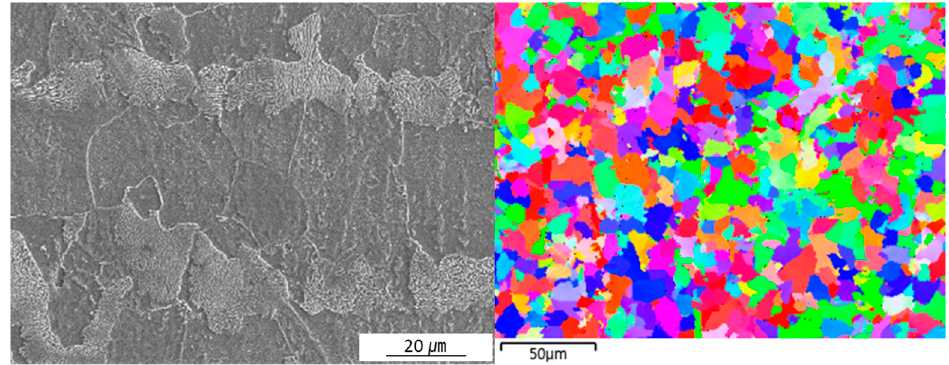
Figure 5. Microstructure and grain morphology of the base metal.